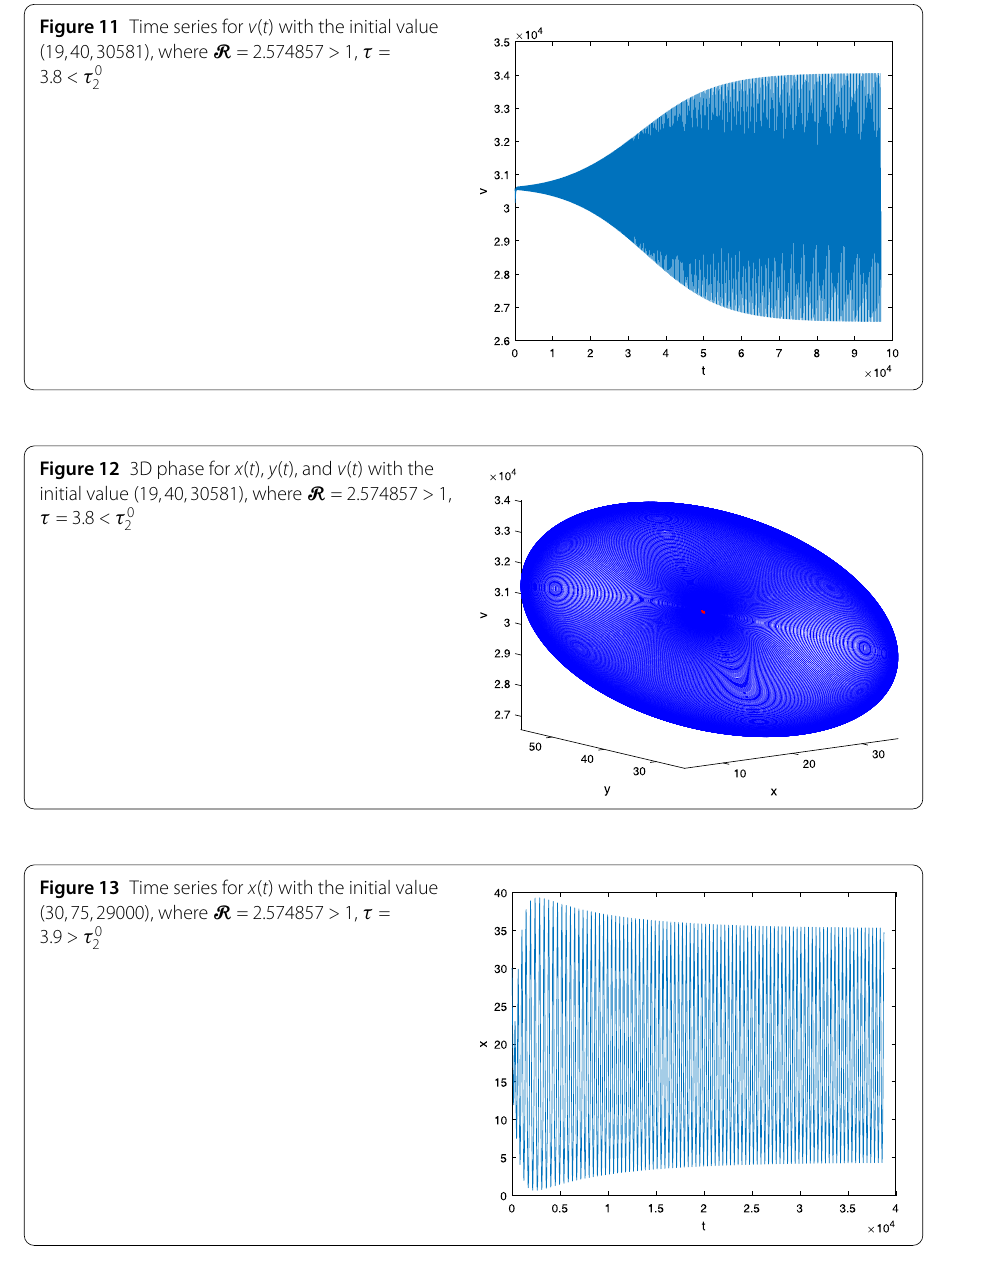
Figure 11 Time series for v ( t ) with the initial value (19,40,30581), where R = 2.574857 > 1, τ =